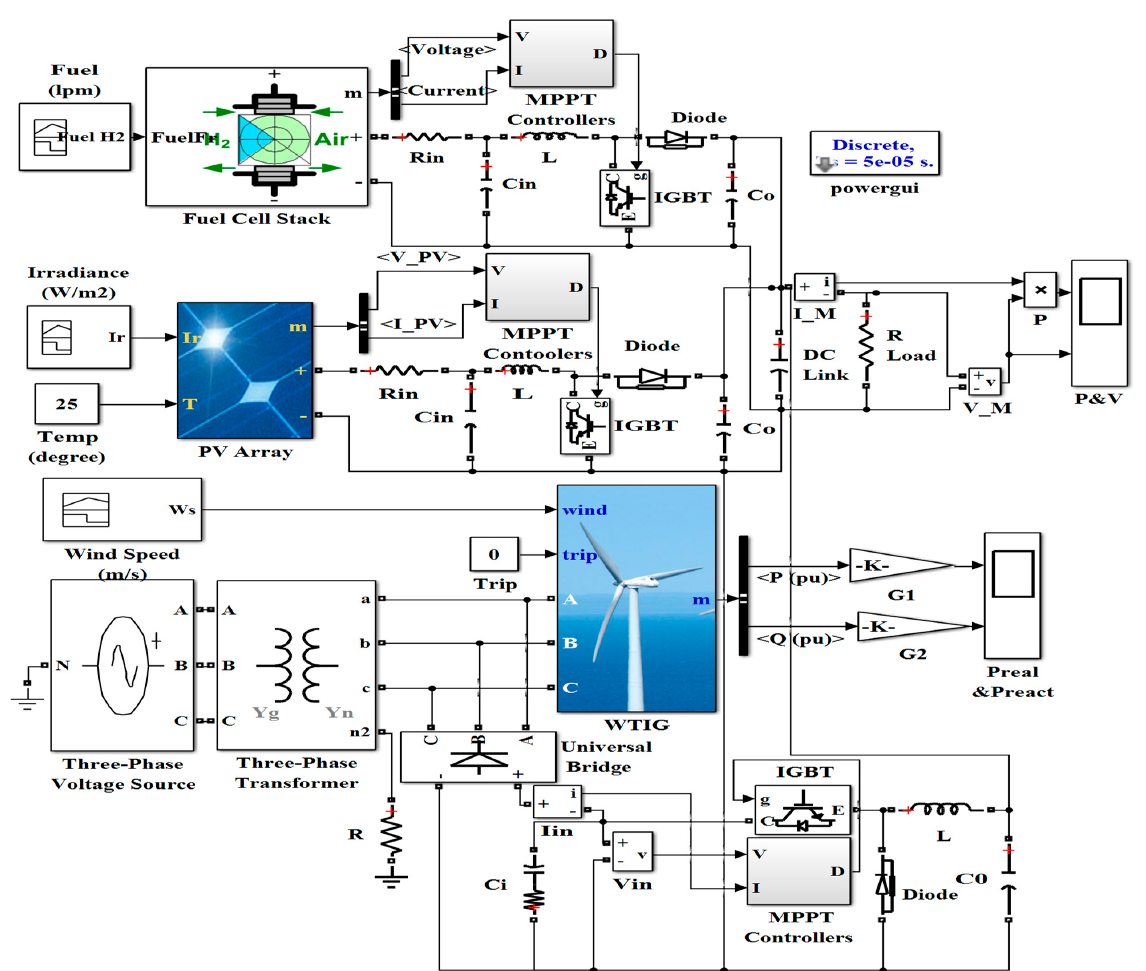
Figure 17. Simulation model of FC–PV–W framework with MPPT controller.